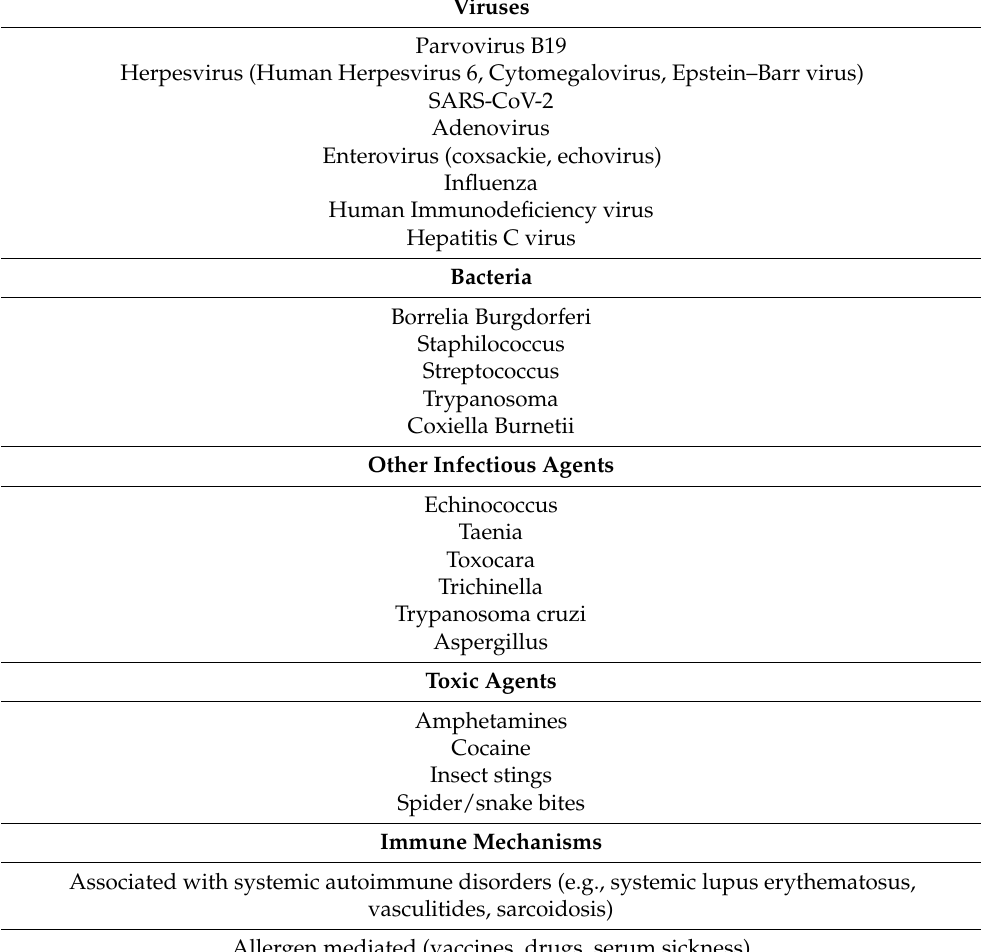
Table 1. Principal etiologies of myocarditis, inflammatory cardiomyopathy, perimyocarditis, and